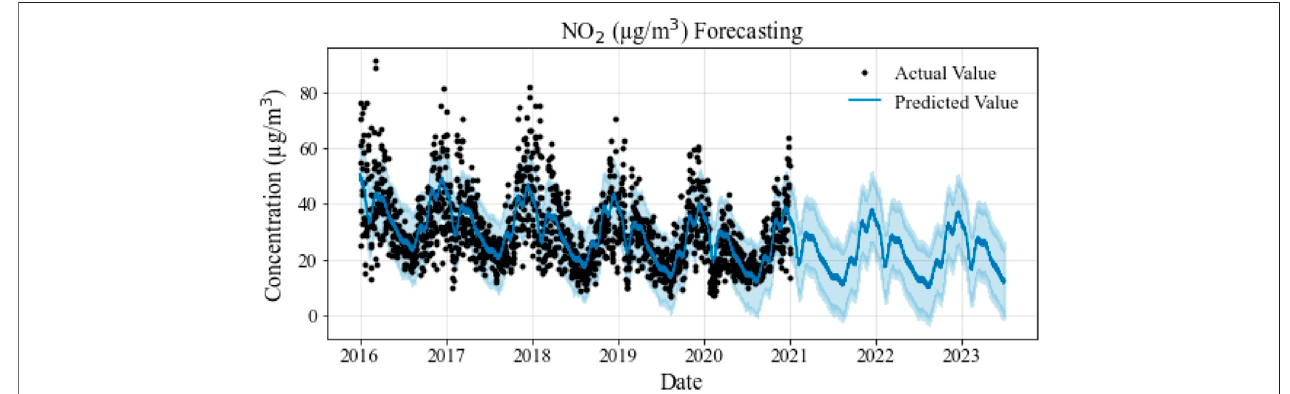
FIGURE 6 | NO 2 (µg/m 3 ) forecasting in jiangsu province.